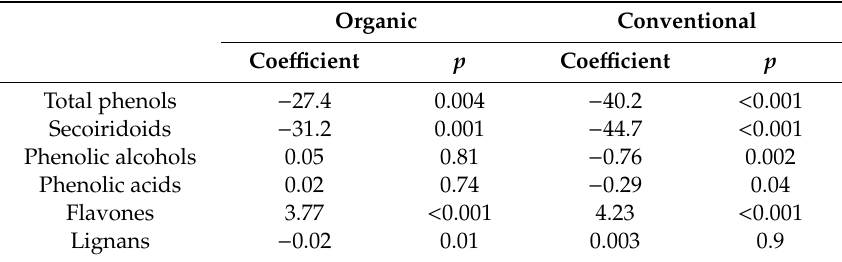
Table 2. Linear regressions (polyphenol content vs. RI) by type of cultivation. Organic